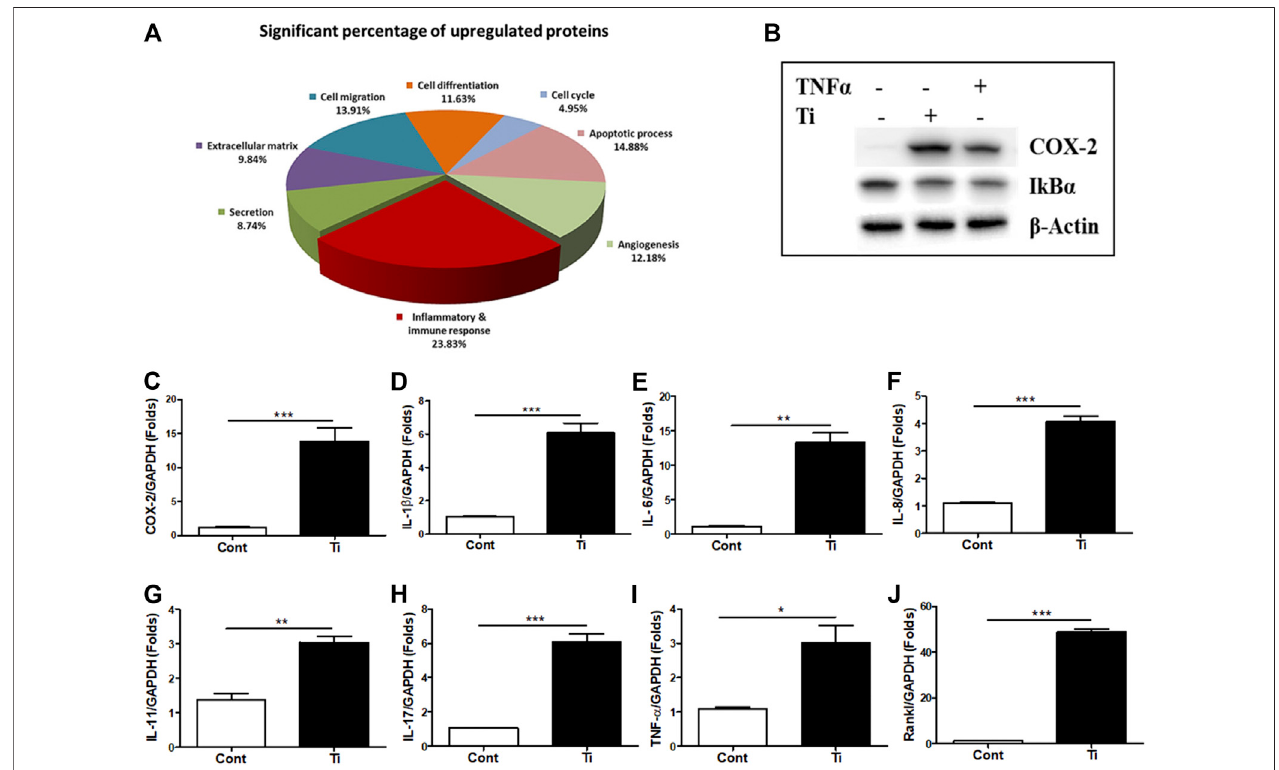
FIGURE 1 | Increased expression of in fl ammatory and immune mediators in Ti particle – stimulated human FLSs. (A) Secretory protein array analysis of the Ti CM. Outoftotalsecretoryproteins, signi fi cantlyupregulated secretoryproteins arecategorized and depictedasapercentage oftheirratiotothecontrolCM. (B) At12 hofTi particletreatment,FLSsshowedinducedexpressionofCOX-2andsuppressedproteinexpressionofI κ B α .TNF- α istakenasapositivecontrol. (C – J) TreatmentofFLSs with Ti particles induced the mRNA expression of the in fl ammatory mediator, COX-2; pro-in fl ammatory cytokines, IL-1 β , IL-6, IL-8, IL-11, IL-17, and TNF- α ; and osteoclastogenicfactor,Rankl.Dataareshownasmean ± SD.Similarresultswereobtainedinthreeindependentexperiments.* p < 0.05,** p < 0.01,and*** p < 0.001vs.